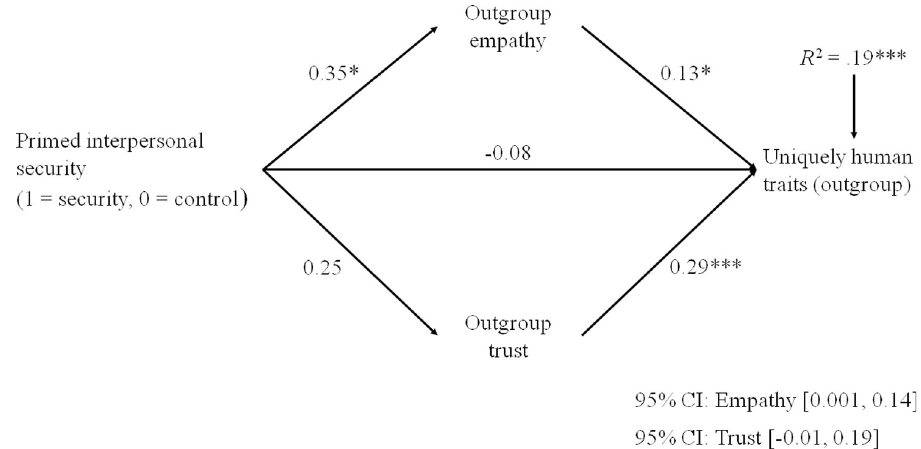
Fig 1. Unstandardized coefficients showing the mediation effect of intergroup emotions in the relationship between primed interpersonal security and the attribution of uniquely human traits to the Roma (Study 2). Note: Participants’ age was entered as covariate, associated with both the mediators and the outcome. The effect size for R 2 is f 2 = .23. � p < .05; ��� p < .001.